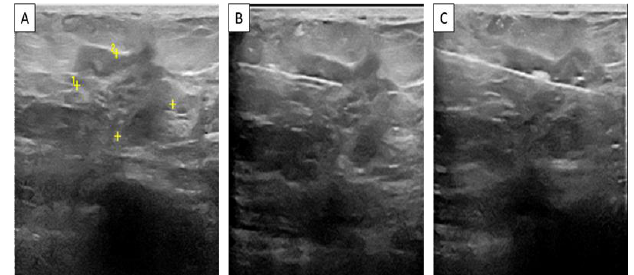
Figure 2 CNB sampling under US guide showing the progress of the needle after